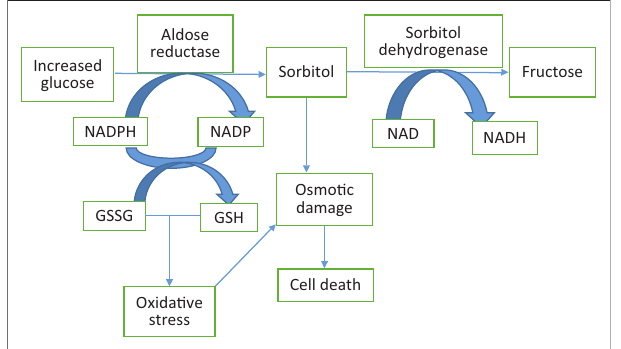
FIGURE 1: Polyol pathway. Hyperglycaemia increases flux through the polyol pathway which metabolises excess glucose. The consumption of nicotinamide adenine dinucleotide phosphate (NADPH) in the initial conversion of glucose to sorbitol results in less NADPH availability for the generation activity of glutathione reductase that maintains the adequate levels of reduced glutathione (GSH), which is an important cellular antioxidant. The depletion of GSH may lead to increased levels of reactive oxygen species, leading to oxidative stress.